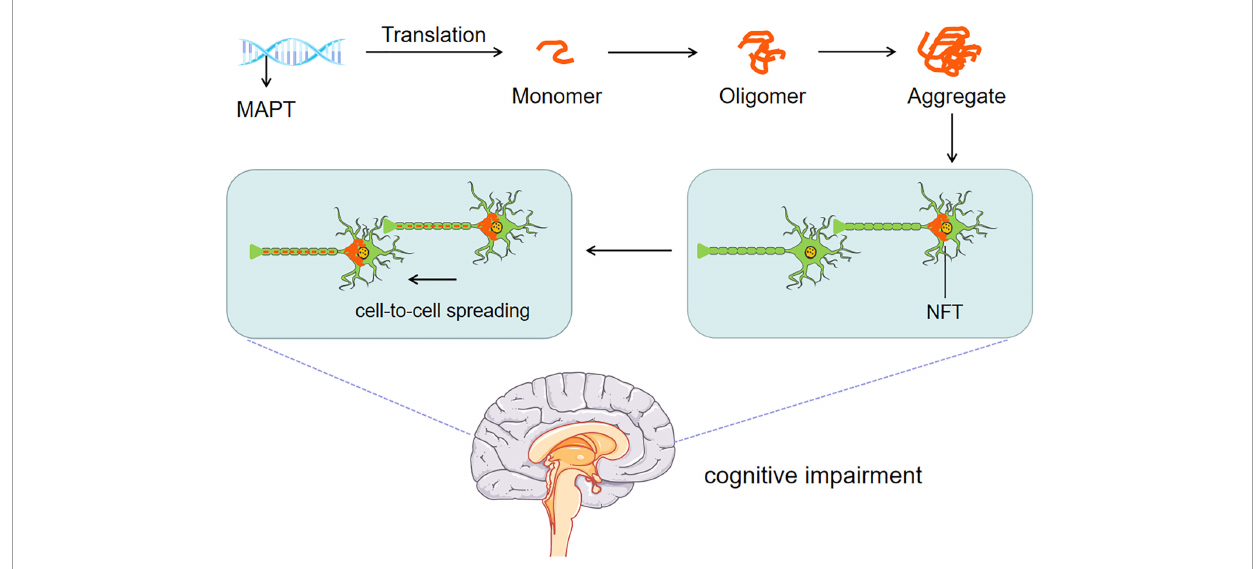
FIGURE2 Tau pathomechanisms. The abnormal transcription and post-translational modification of MAPT gene intertwine with each other to form NFTs. NFTs affect axonal transport, synaptic plasticity, and cytoskeleton stability of neurons. Persistent diffusion and cell to cell p-Tau spreading eventually lead to cognitive